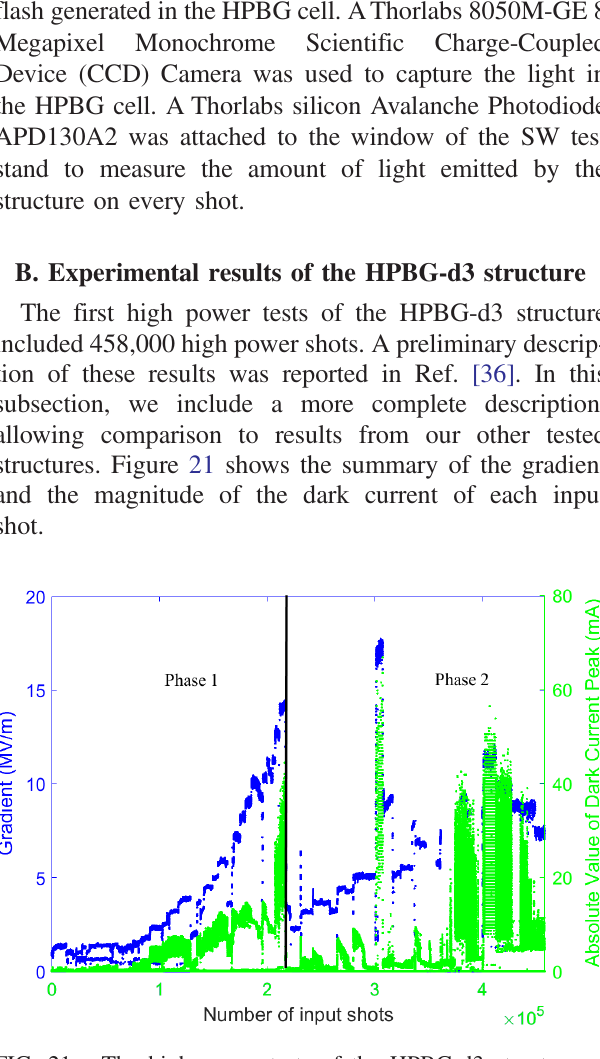
FIG. 21. The high power tests of the HPBG-d3 structure of gradient (blue) and the magnitude of the dark current (green) from the downstream Faraday cup.